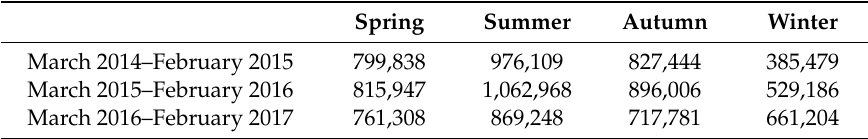
Table 2. Total number of tourists during each